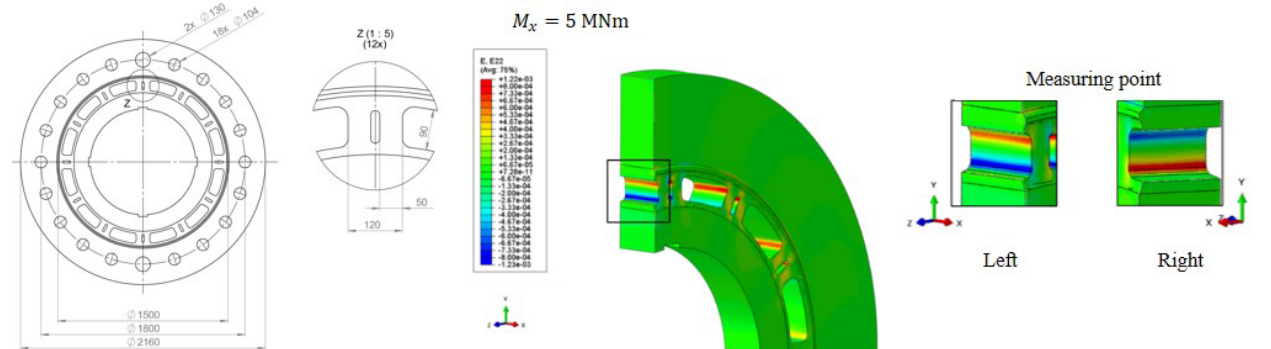
Figure 11. Torque element dimensions and the distribution of the nominal strain in the y direction at the measuring point of torque under nominal torque of 5MNm.